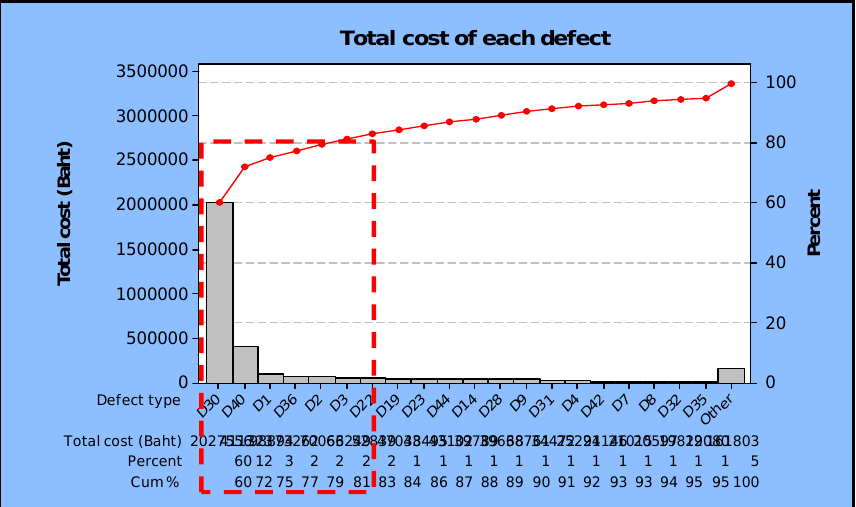
Fig. 3. Prioritized final product parameters based on total failure